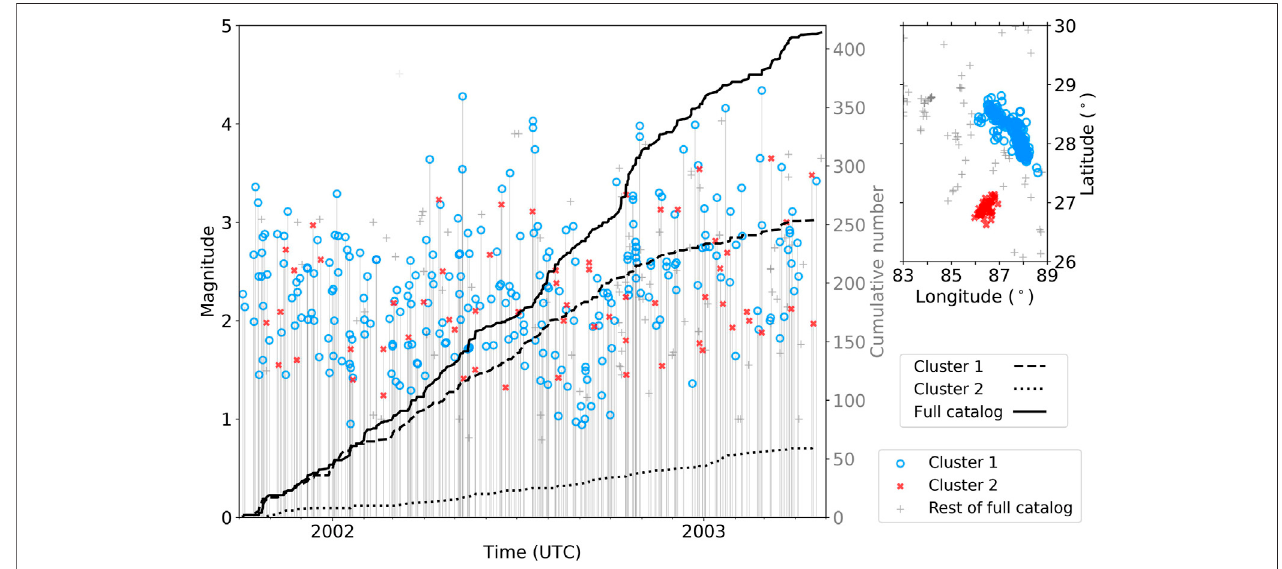
FIGURE5| LocalmagnitudesofearthquakesversustimeforCluster1(bluecircle),Cluster2(redcross)andtheremainingeventsofthefullcatalog(graycross),are shownintheleftaxis.Solid,dashedanddottedblacklinesrepresentthecumulativenumberofeventsversustimeforthefullcatalog,Cluster1andCluster2,respectively (right axis). Inset depicts the spatial distribution of the events.